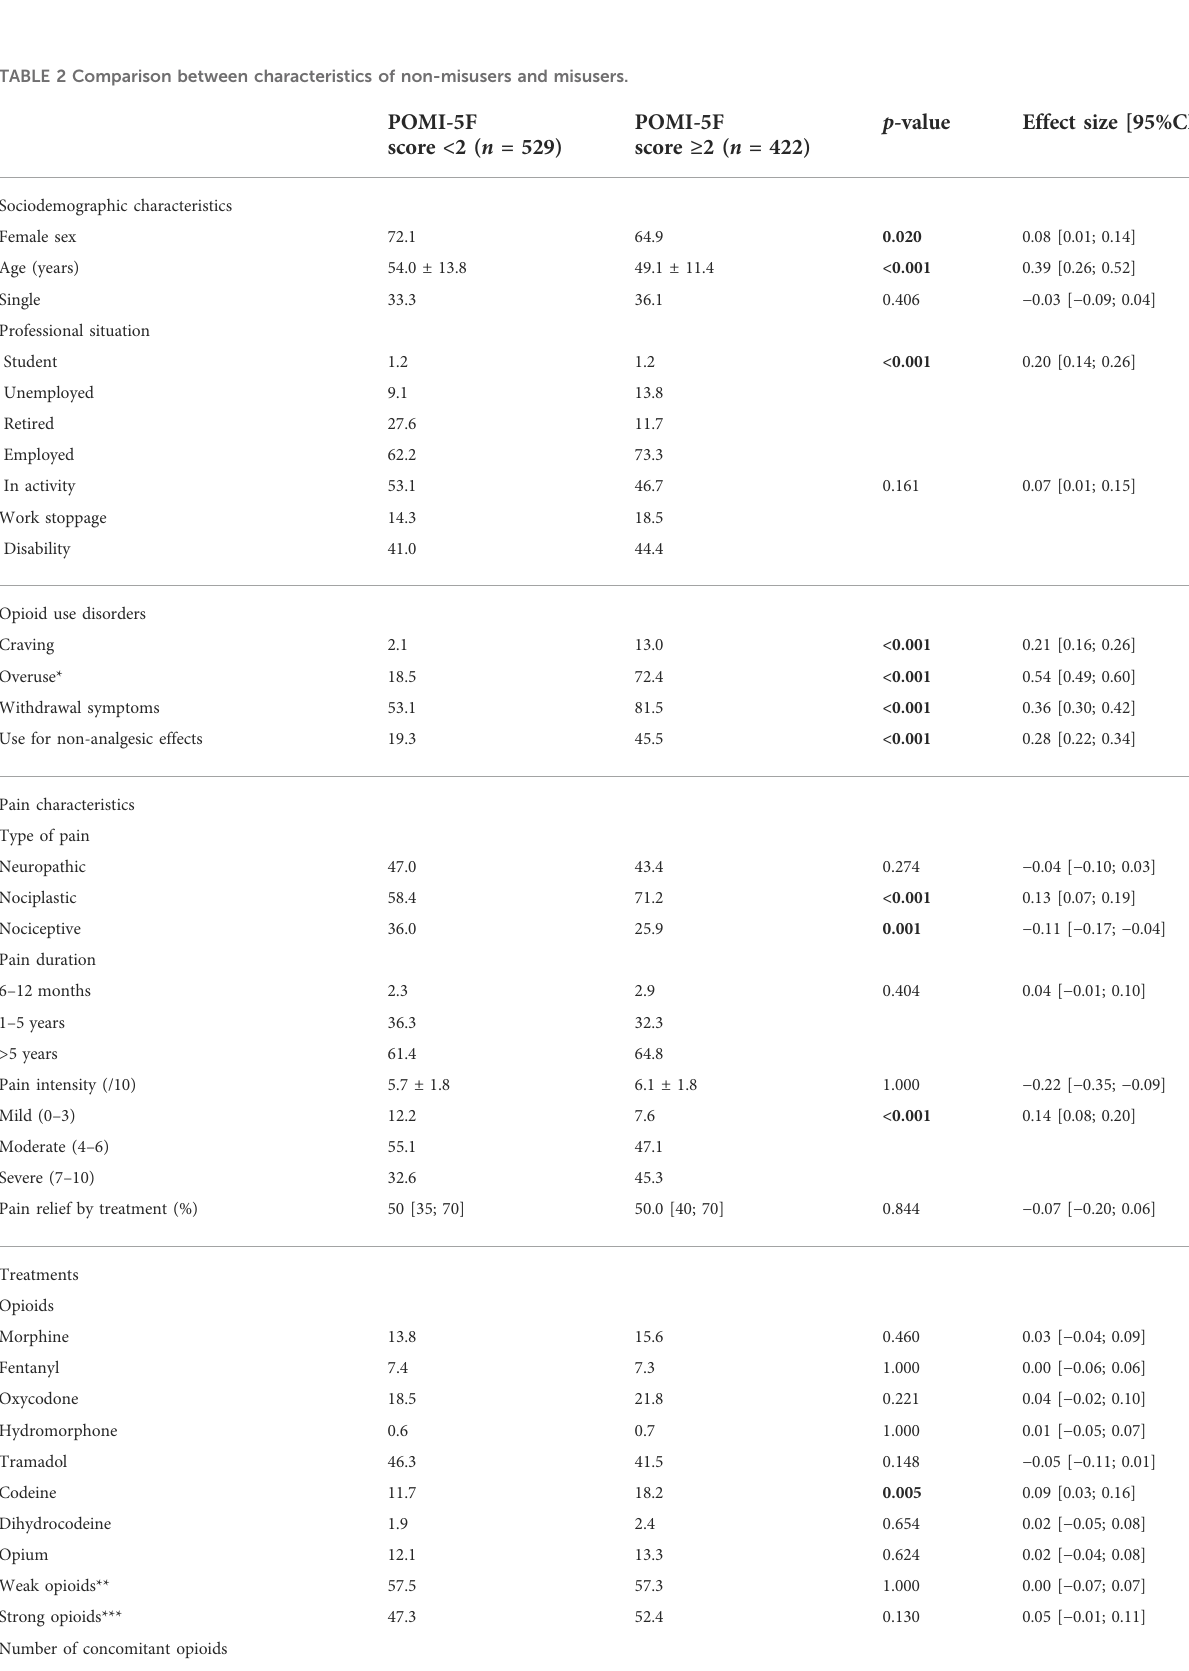
TABLE 2 Comparison between characteristics of non-misusers and